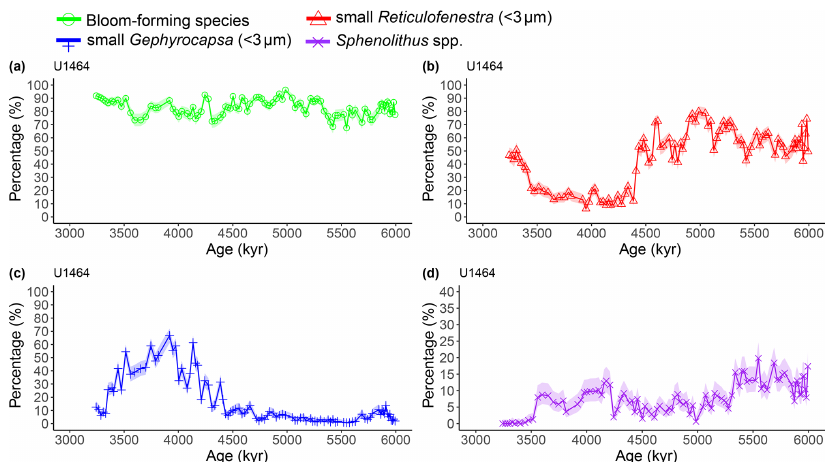
Figure A2. Latest Miocene to early Pliocene relative abundances (%) of the dominant calcareous nannofossil species at IODP Site U1464. (a) Bloom-forming species ( < 5µm Reticulofenestra and < 3µm Gephyrocapsa combined; green circles), (b) small ( < 3µm) Reticulofen- estra (red triangles), (c) small ( < 3µm) Gephyrocapsa (blue plus signs), and (d) Sphenolithus spp. (purple crosses). Shaded areas represent 95% confidence intervals (see Methods). Note the different y axis scale in panel (d) .